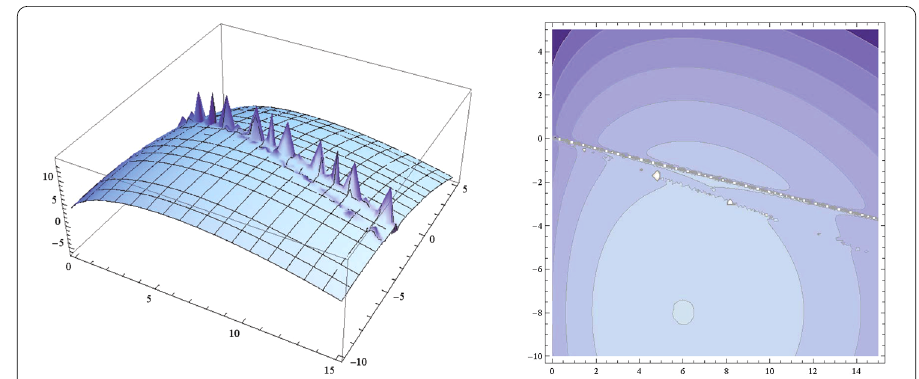
Figure 2 Graphs of (cid:2) d ( ς 1 , ς 2 ) and its contour for Example